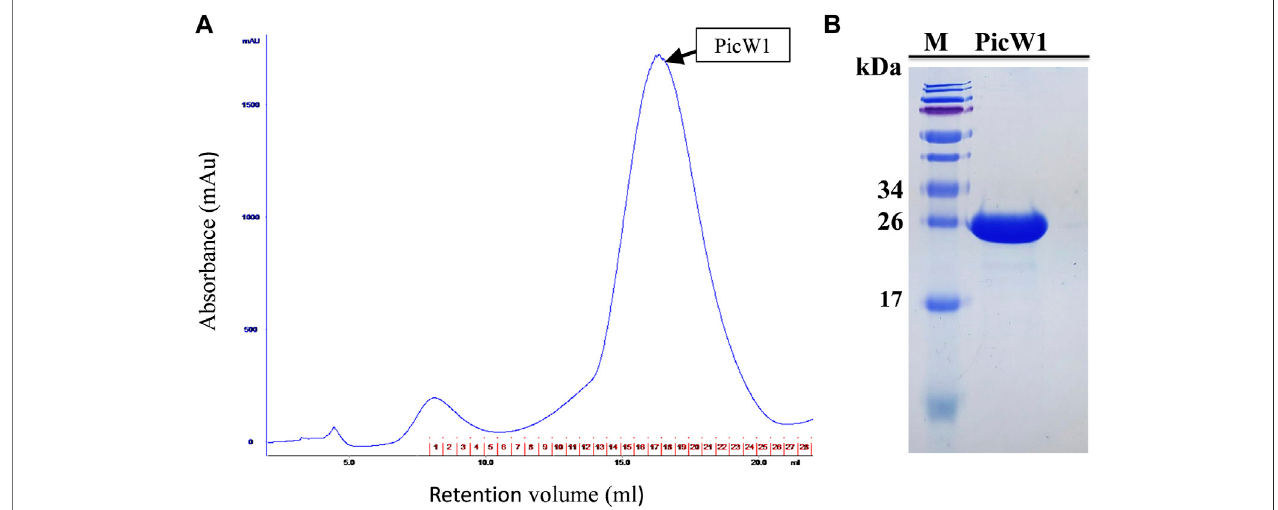
FIGURE3| Puri fi cationofPicW1bysize-exclusionchromatography. (A) Gel fi ltrationchromatographyofPicW1onaSuperdex200 pg10/300 GLcolumn.Elution was monitored at 280 nm at a fl ow rate of 0.4 ml/min. The red numbers represent the tubes of protein components collected using the AKTA collector. (B)